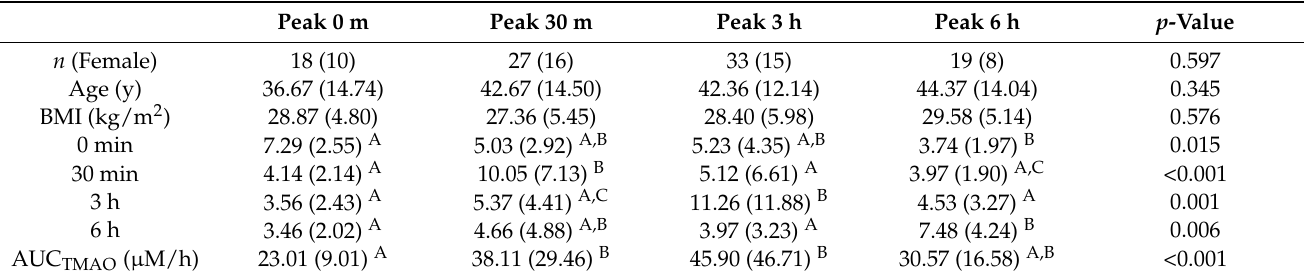
Figure 2. Postprandial TMAO exposure is different by sex and age. Exposure to plasma TMAO during a six-hour window following a high-fat, high-sugar MMTT differs with age in males and females and correlates to fasting TMAO plasma concentrations. ( A ) Exposure to TMAO increases with age in females but not in males ( p -value = 0.0112). ( B ) Exposure to TMAO correlates with fasting TMAO concentrations in males and females but is higher in males (female, r = 0.41; male, r = 0.6). Table 3. Plasma TMAO concentrations by TMAO-response group. Plasma TMAO concentrations ( µ M) at 0 min, 30 min, 3 h, and 6 h in individuals grouped by their TMAO response to an MMTT without choline, carnitine, or